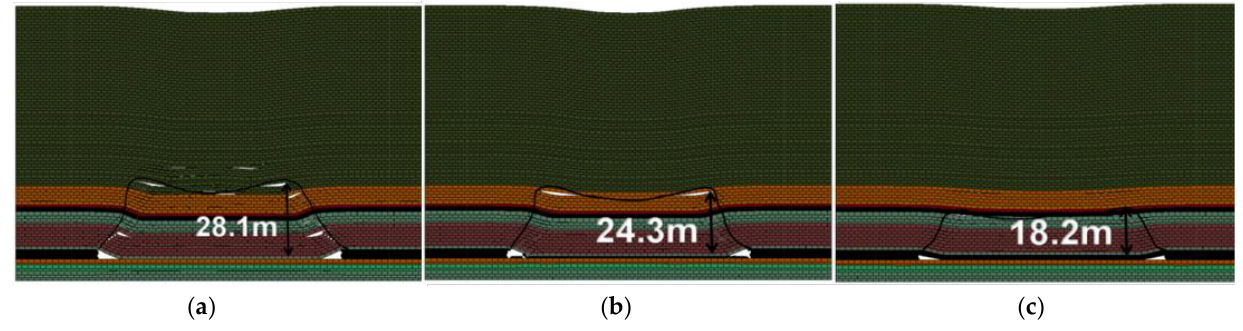
Figure 9. Simulation results of the collapse pattern of thin bedrock under different mining thicknesses.